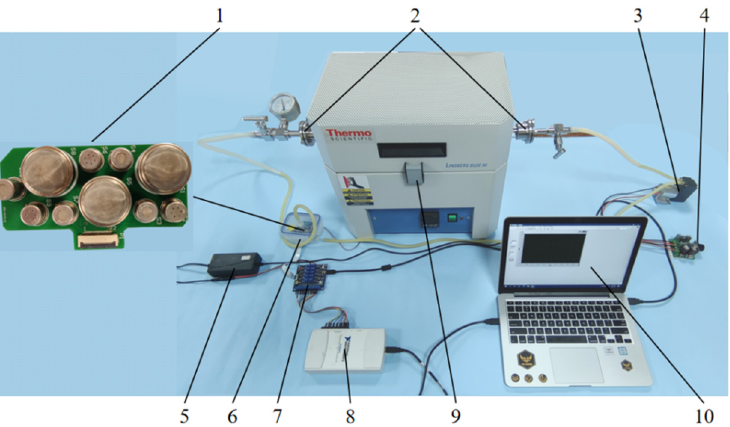
Figure 2. Thermal cracking-based artificial olfactory system for soil total nitrogen detection system. 1. Gas sensor array 2. Vacuum flange 3. Vacuum pump 4. PWN module 5. 12V power supply 6. Gas chamber 7. Signal processing circuit 8. NI data acquisition card 9. Muffle furnace 10. Computer. Table 1. Sensor Type Table.